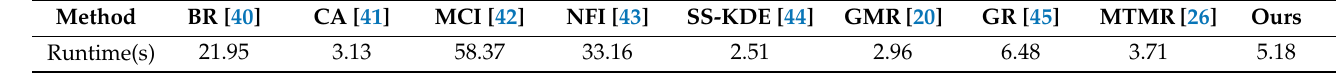
Table 3. Average runtime comparison on the RGBT-Saliency